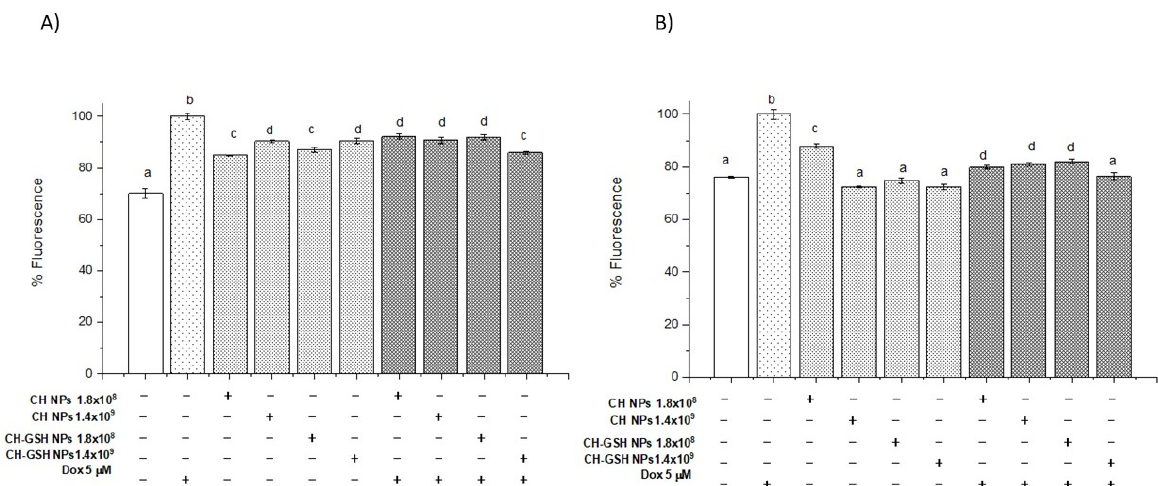
Figure 6. Combined exposure to Dox and CH-GSH NPs or CH-NPs reduced ROS levels. The cells were exposed to Dox for 12 h and then 2 h with CH-GSH NPs. ( A ) MCF-7 and ( B ) MDA MB-231 cells. Bars with equal letters indicate no significant differences between the means (Tukey’s test, p <0.05).